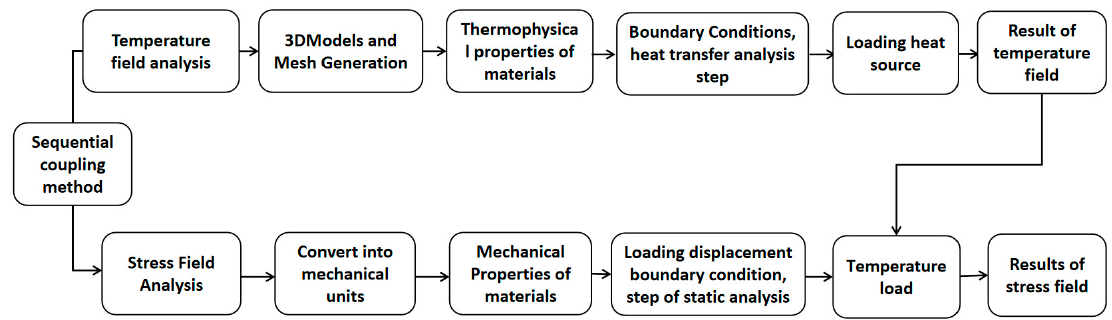
Figure 4. Residual stress simulation flowchart.